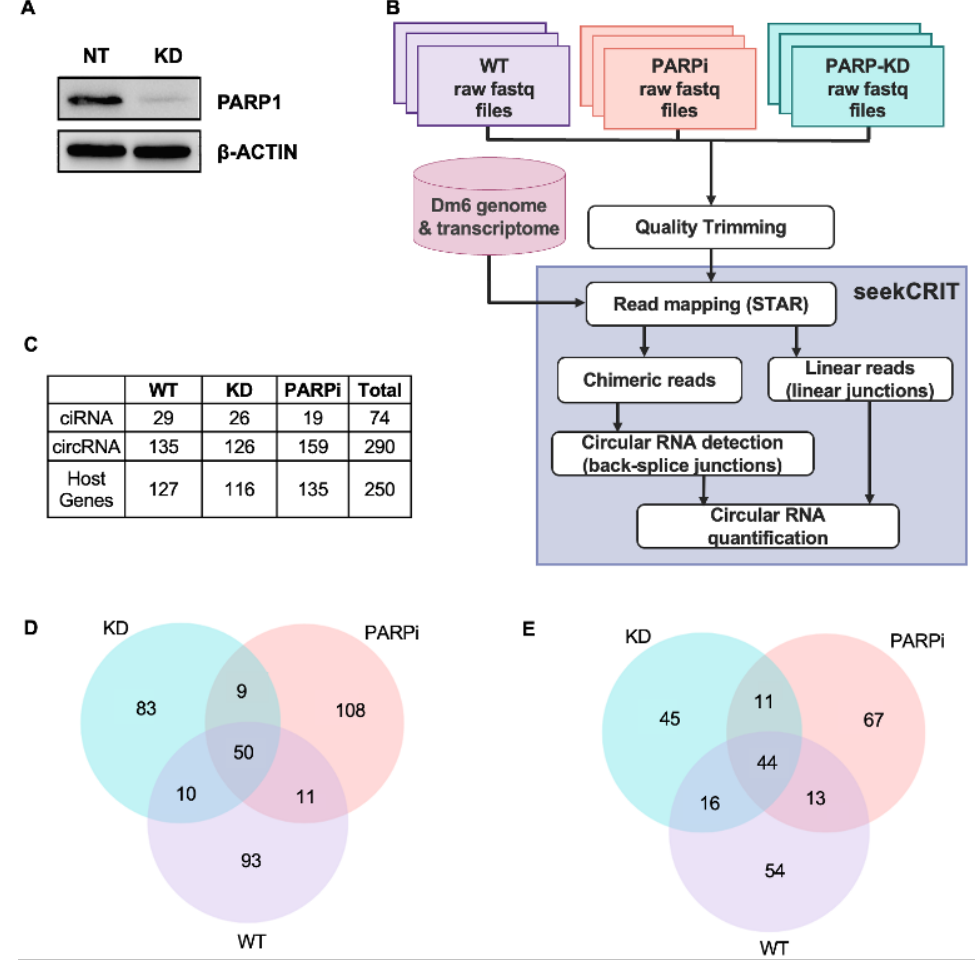
Figure 1. Detection of circRNAs in paired-end sequencing data from total RNA using seekCRIT. ( A ) Western blot analysis of PARP1 depletion by siRNA. β -actin used as loading control. ( B ) Schematic representation of seekCRIT computational pipeline [18]. ( C ) Number of intronic circRNAs and exonic circRNAs (“backsplice junctions”), discovered by seekCRIT and the host genes they come from in the various experimental conditions. ( D ) Overlap of circRNAs between WT, PARPi, and PARP KD conditions. ( E ) Overlap of the circRNA-producing genes (host genes) between WT, PARPi, and PARP KD conditions.